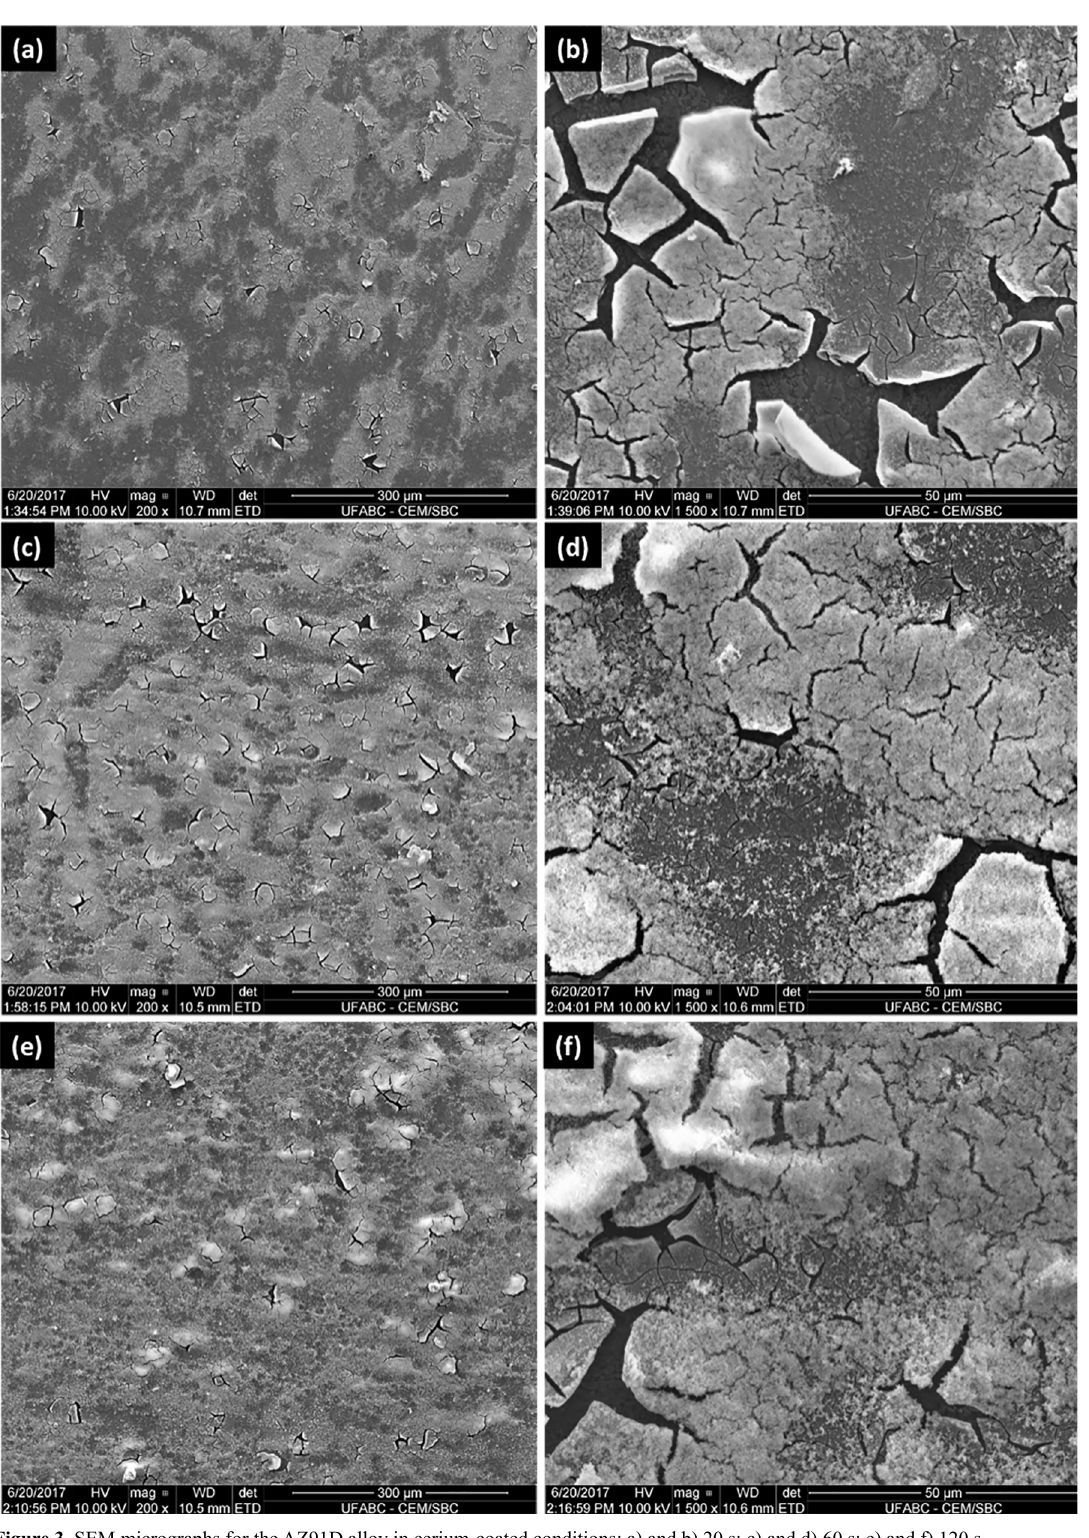
Figure 3. SEM micrographs for the AZ91D alloy in cerium-coated conditions: a) and b) 20 s; c) and d) 60 s; e) and f) 120